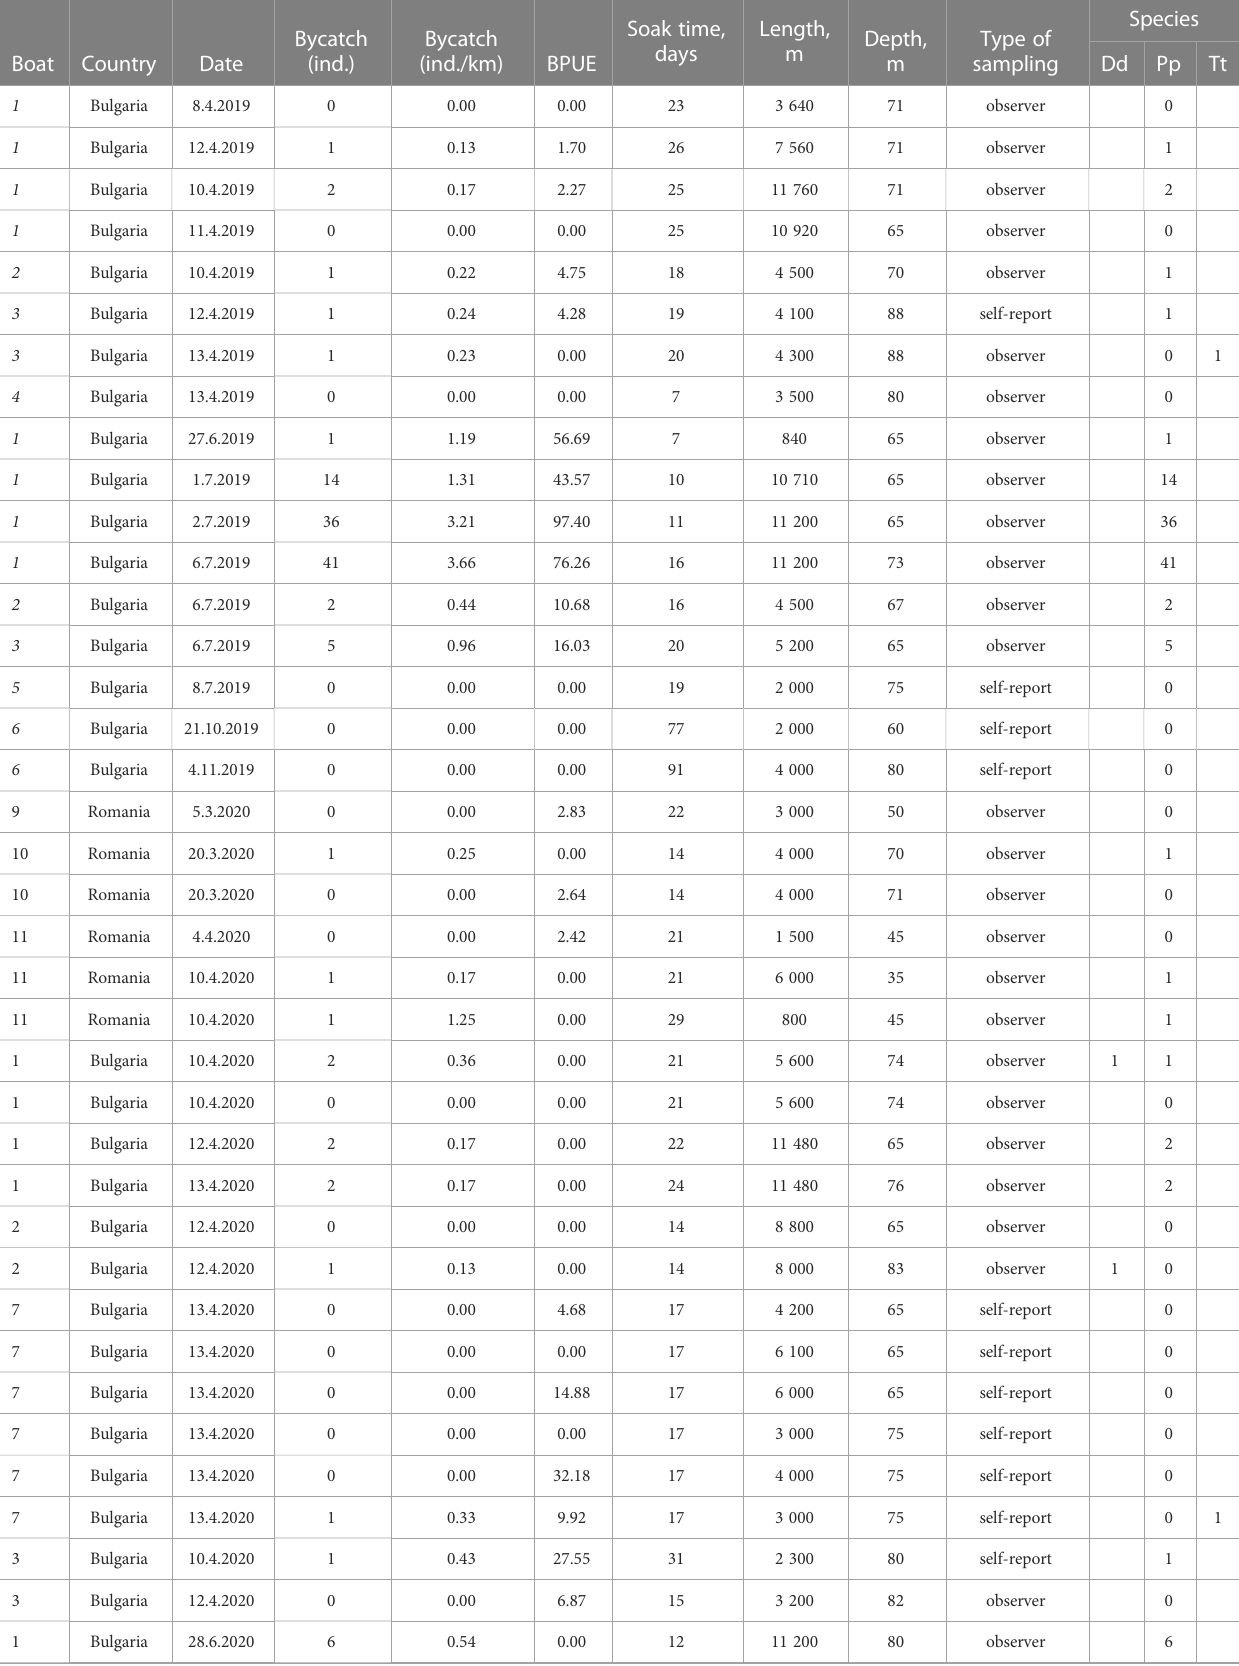
TABLE 2 Results from bycatch onboard